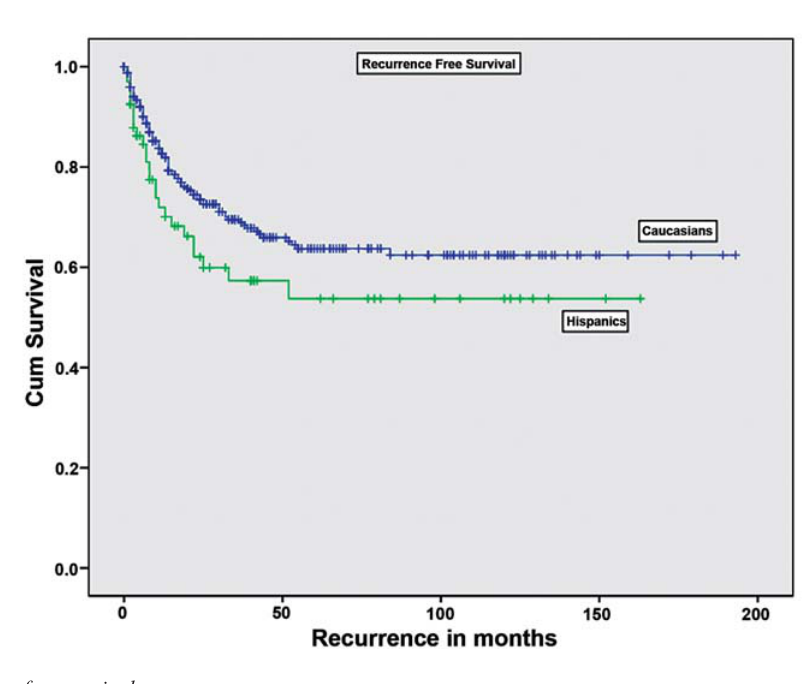
Figure 2 – Recurrence-free survival.